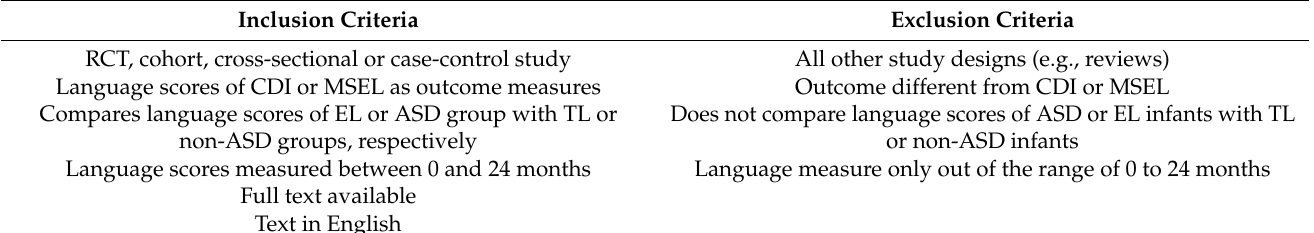
Table 2. Inclusion and exclusion criteria for the search.